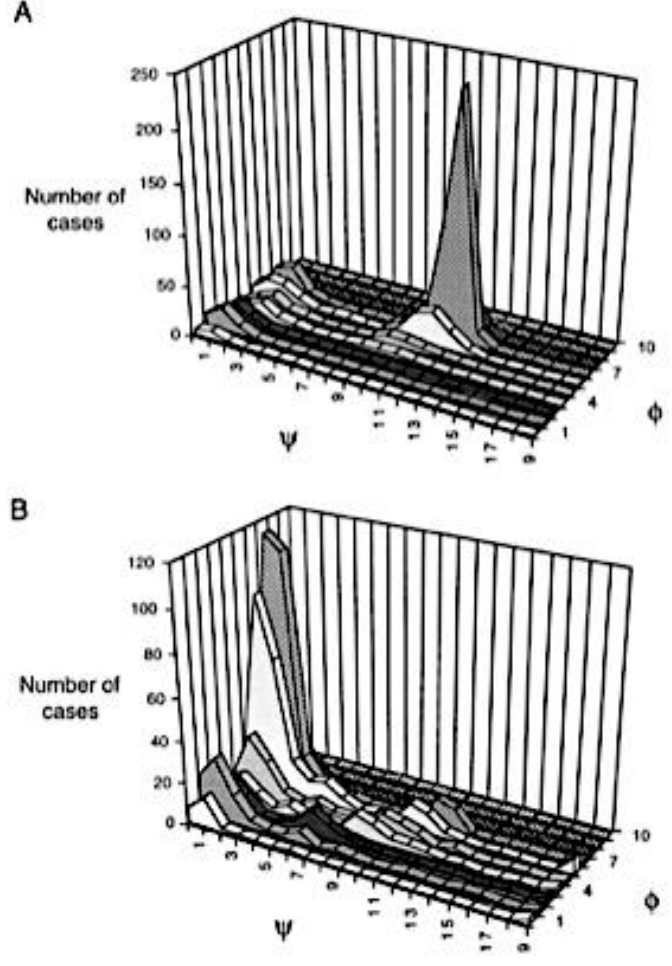
Figure 3. Conformational distribution of alanine residues inferred from the protein data sets. ( A ) The complete data set including residues in well-defined secondary structures. ( B ) Only alanine residues in coils outside of right-handed helical and β -sheet structures were considered. Each number on the abscissae represents an 18° interval starting at −180°. Taken from [16] with permission, 1995, Academic Press .